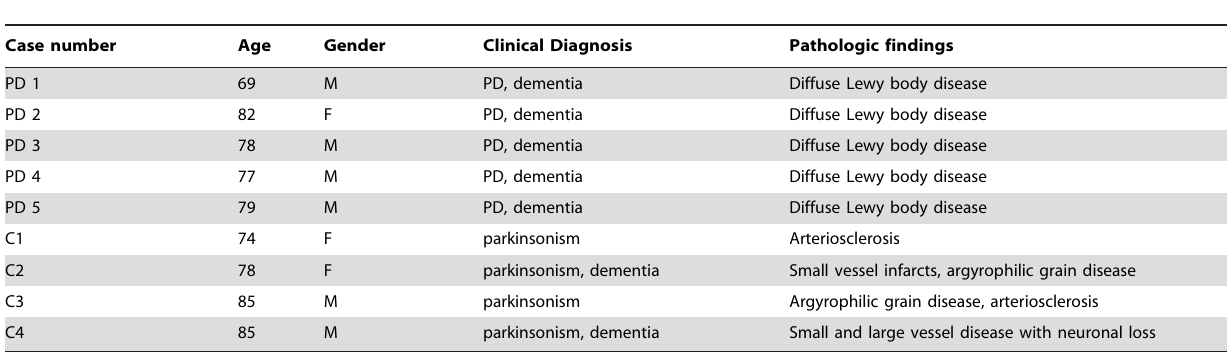
Table 2. Clinical and demographic information for autopsy cases utilized for binding